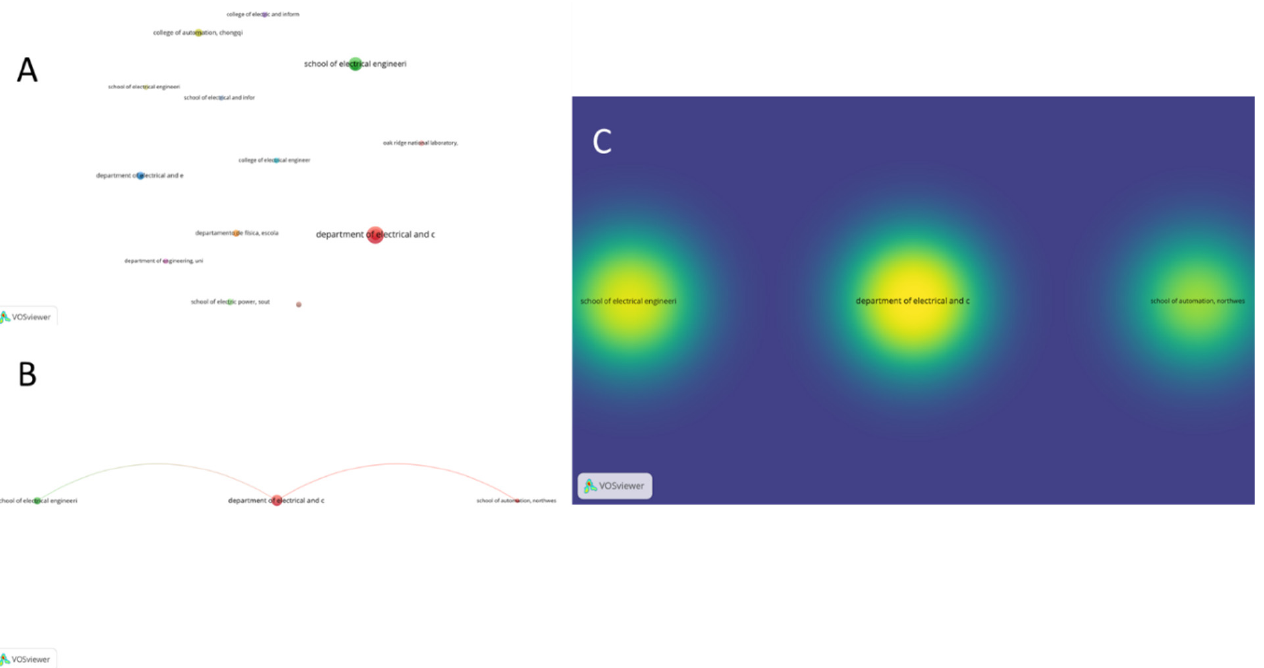
Figure 7. Co-authorship analysis for organization network ( A ) and density visualization ( C ). These network and visualization density maps ( A and C respectively) depicted three items with two links and two clusters. Eighteen out of 2292 organizations met the criteria of at least five documents to be published by an organization and minimum citation count was set to zero. The network visualization ( B ) shows only the connected organizations.